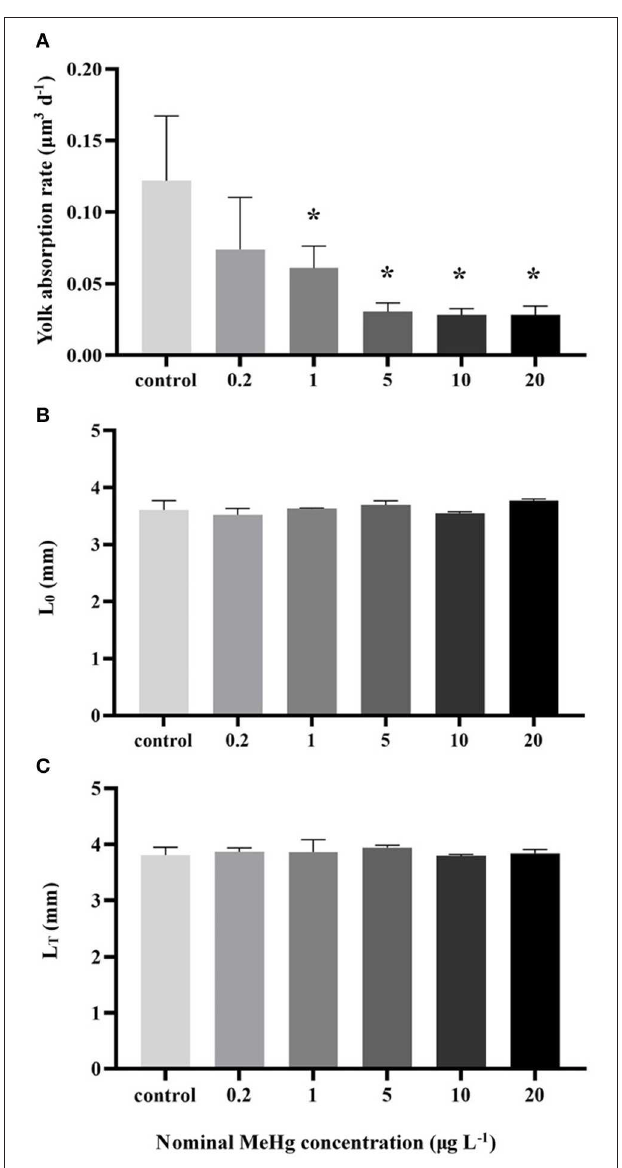
FIGURE 3 | (A) Yolk absorption rate, (B) body length of newly hatched larvae (L 0 ) and (C) final body length (L T ) of the larvae by MeHg exposure (mean ± S.D.; n = 3; * indicated significant difference compared to the control group at p < 0.05).